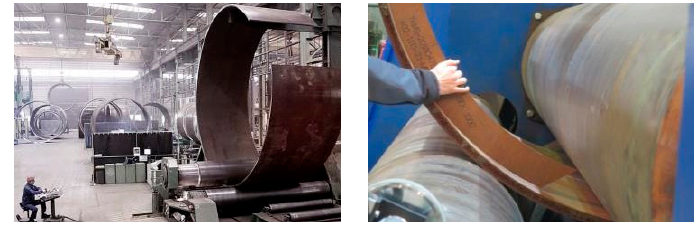
Figure 1. Roll bending machine ( left ) and result control with templates ( right ).